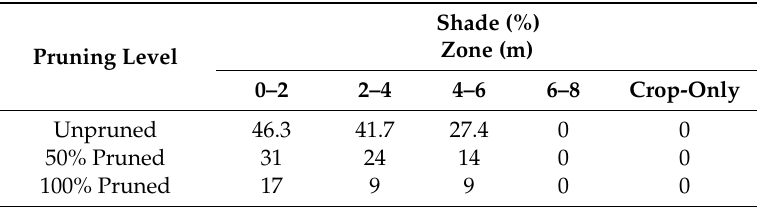
Table 1. Measured shade values used to set up the